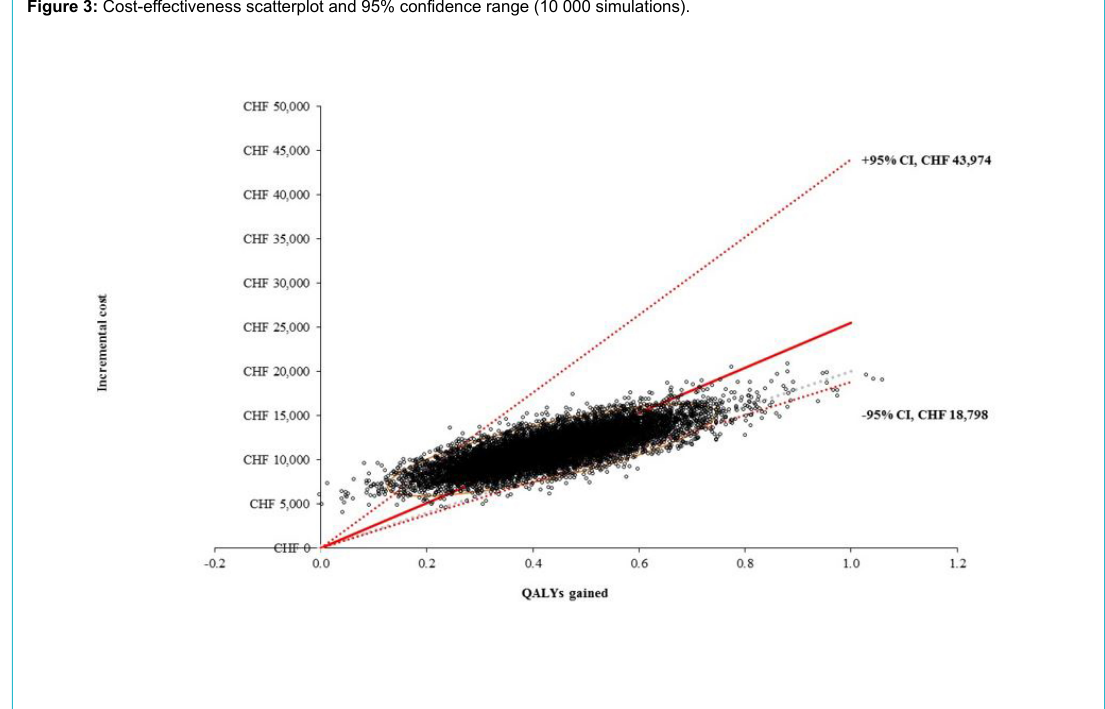
Figure 3: Cost-effectiveness scatterplot and 95% confidence range (10 000